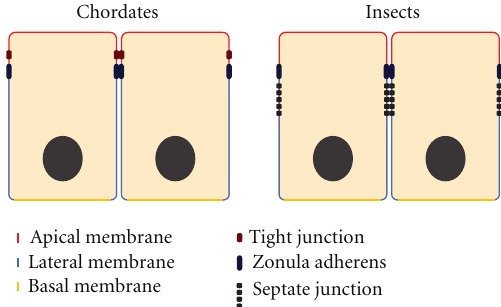
Figure 1: Organization of epithelial tissues. Epithelial cells are polarized along an apical-basal axis. The apical domain faces a lumen or the environment, the lateral domain contacts neighboring cells, and the basal domain is anchored to the basement membrane. This polarized architecture sustains unidirectional functions, such as vectorial transport. The apical and lateral domains are segregated by the zonula adherens, which is a circumferential adherens junc- tion maintaining intercellular adhesion within epithelial tissues. In chordates epithelia, paracellular di ff usion is limited by tight junctions, which sit apical to the zonula adherens. In insect, this sealing function is assumed by septate junctions that are established basal to the zonula